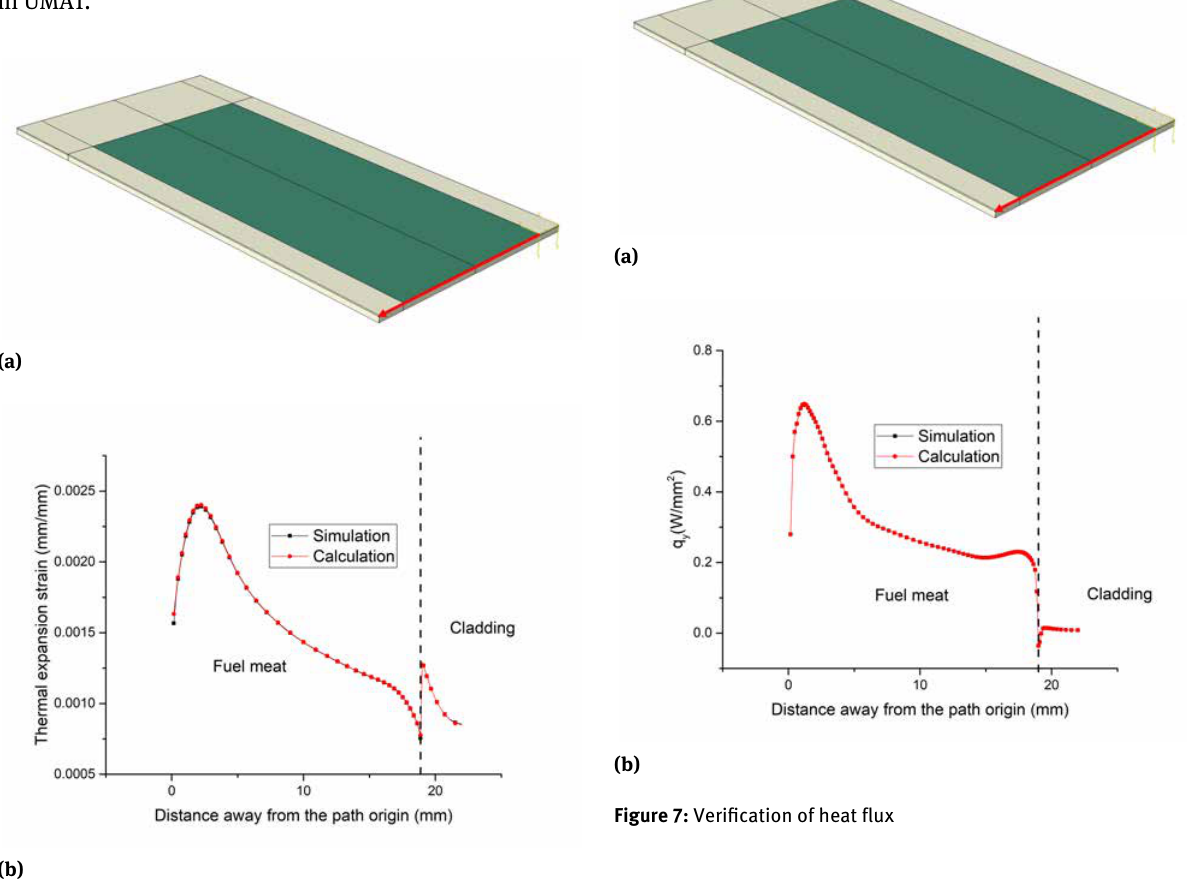
Figure 6: The verification of thermal expansion